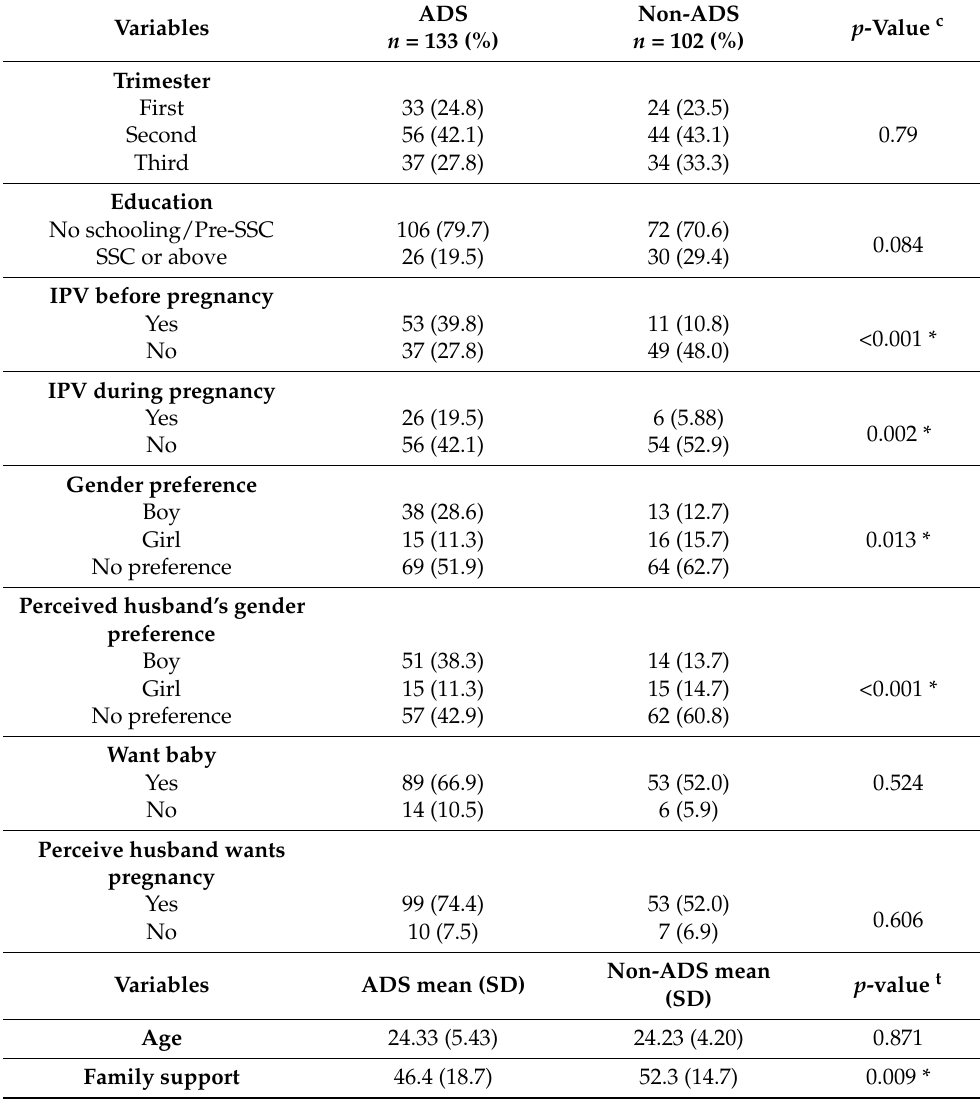
Table 2. Bivariate analysis of social determinants with antenatal depressive symptoms among pregnant women in MAA health camps in rural